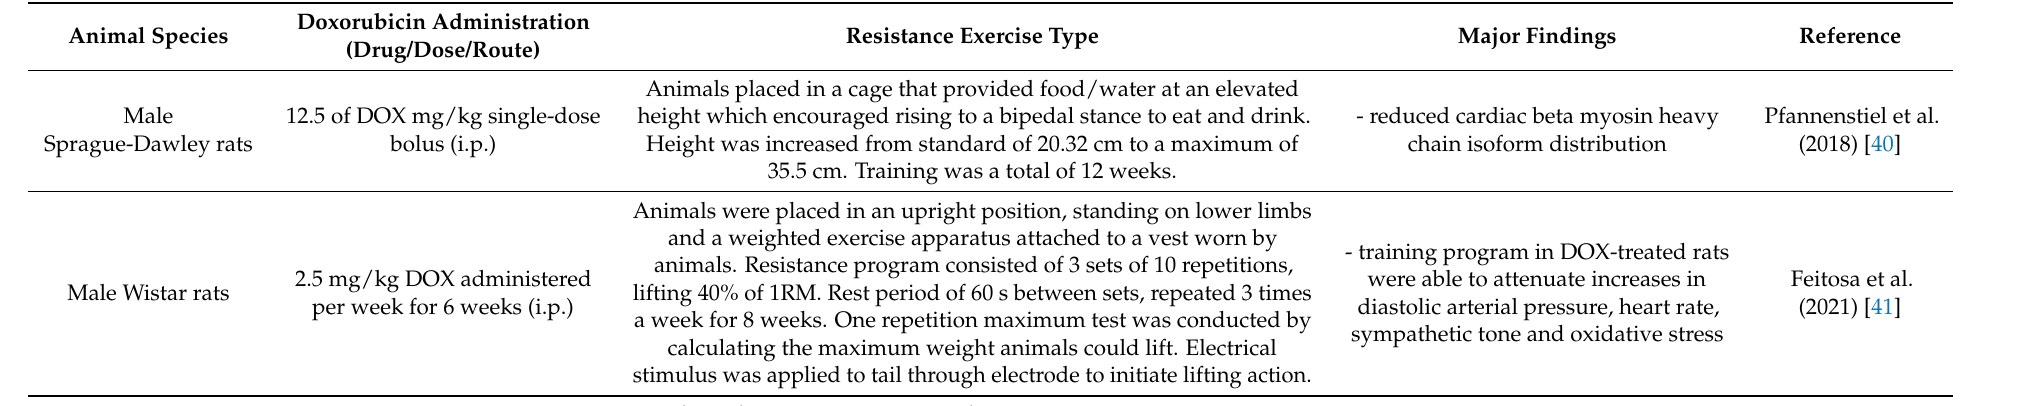
Table 2. Pre-clinical Resistance exercise